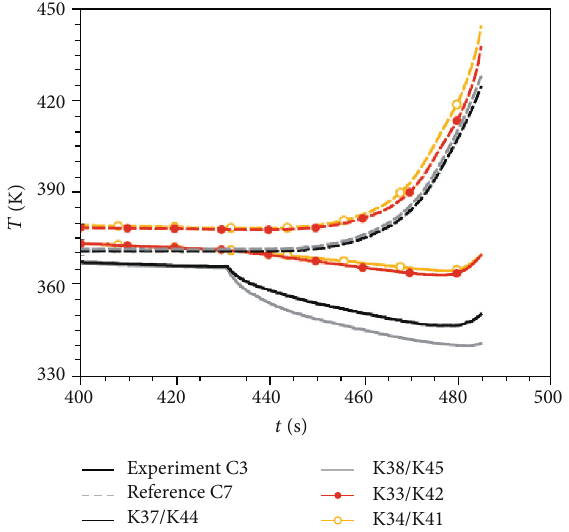
Figure 23: Temperatures on AKTiV and the reference set-up. Solid curves indicate thermocouple signals K29-K38 of the cooled experiment AKTiV while dashed curves represent signals K39-K46 of the uncooled reference with an identical set-up [42].